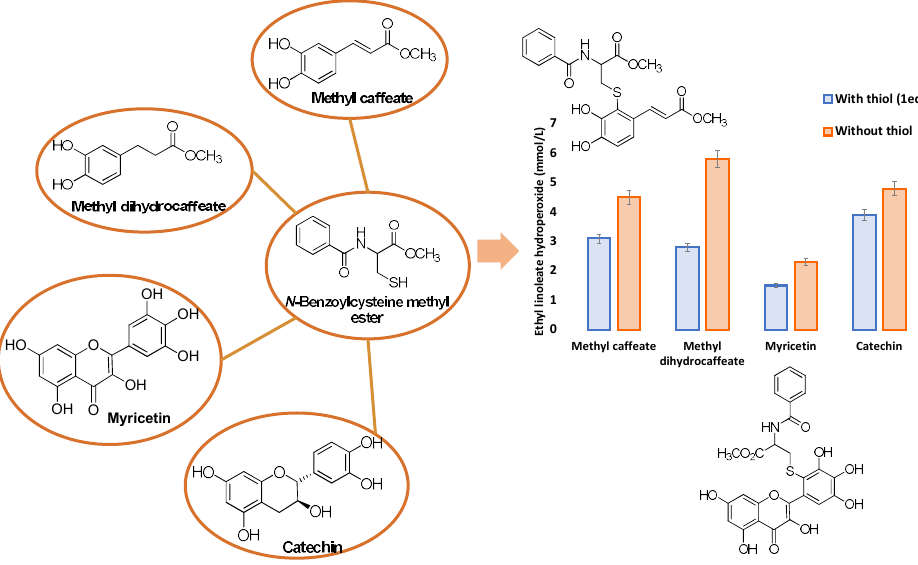
Figure 5. Antioxidant activity of methyl caffeate, methyl dihydrocaffeate, myricetin or catechin with or without equimolar amounts of N -benzoylcysteine methyl ester against 2,2′-azobis (2,4- dimethylvaleronitrile)-induced lipid oxidation for 4 h.